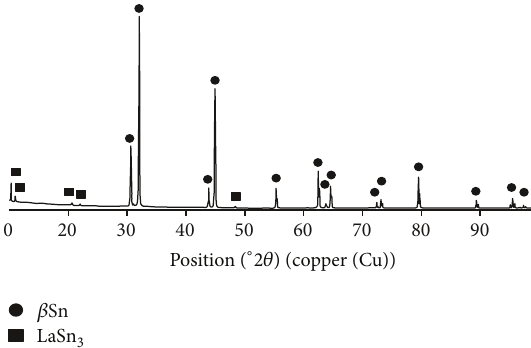
Figure 9: Point analysis of LaSn 3 composition in Sn2La solder.